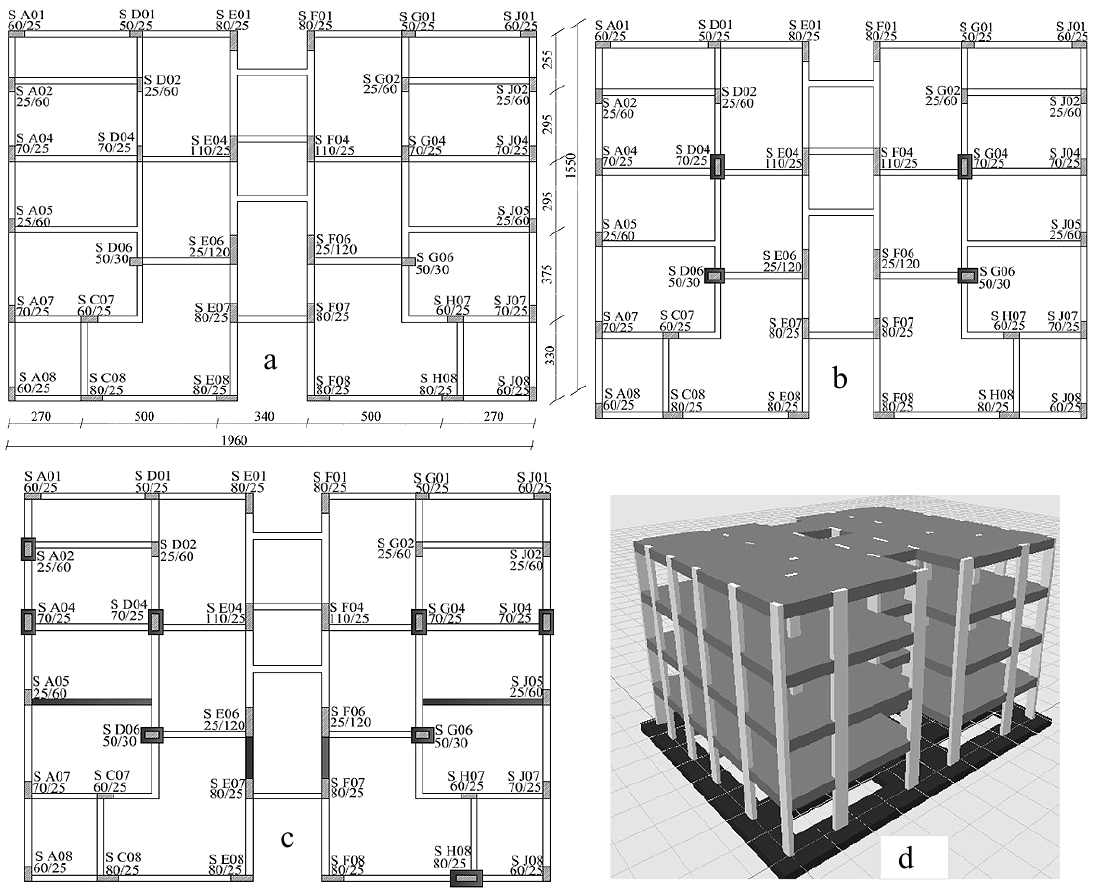
Fig. 1. Typical plan of buildings: (a) Existing; (b) Jacketed; (c) Strengthening by BSO; (d) 3D view of existing